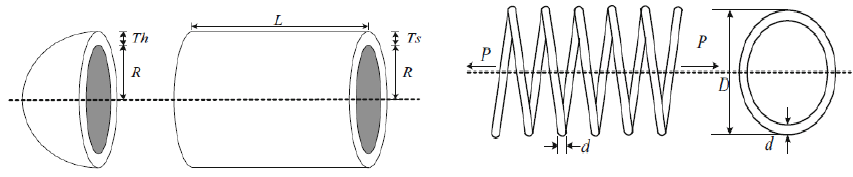
Figure 7. Design engineering problems (Engp1 and Engp2).